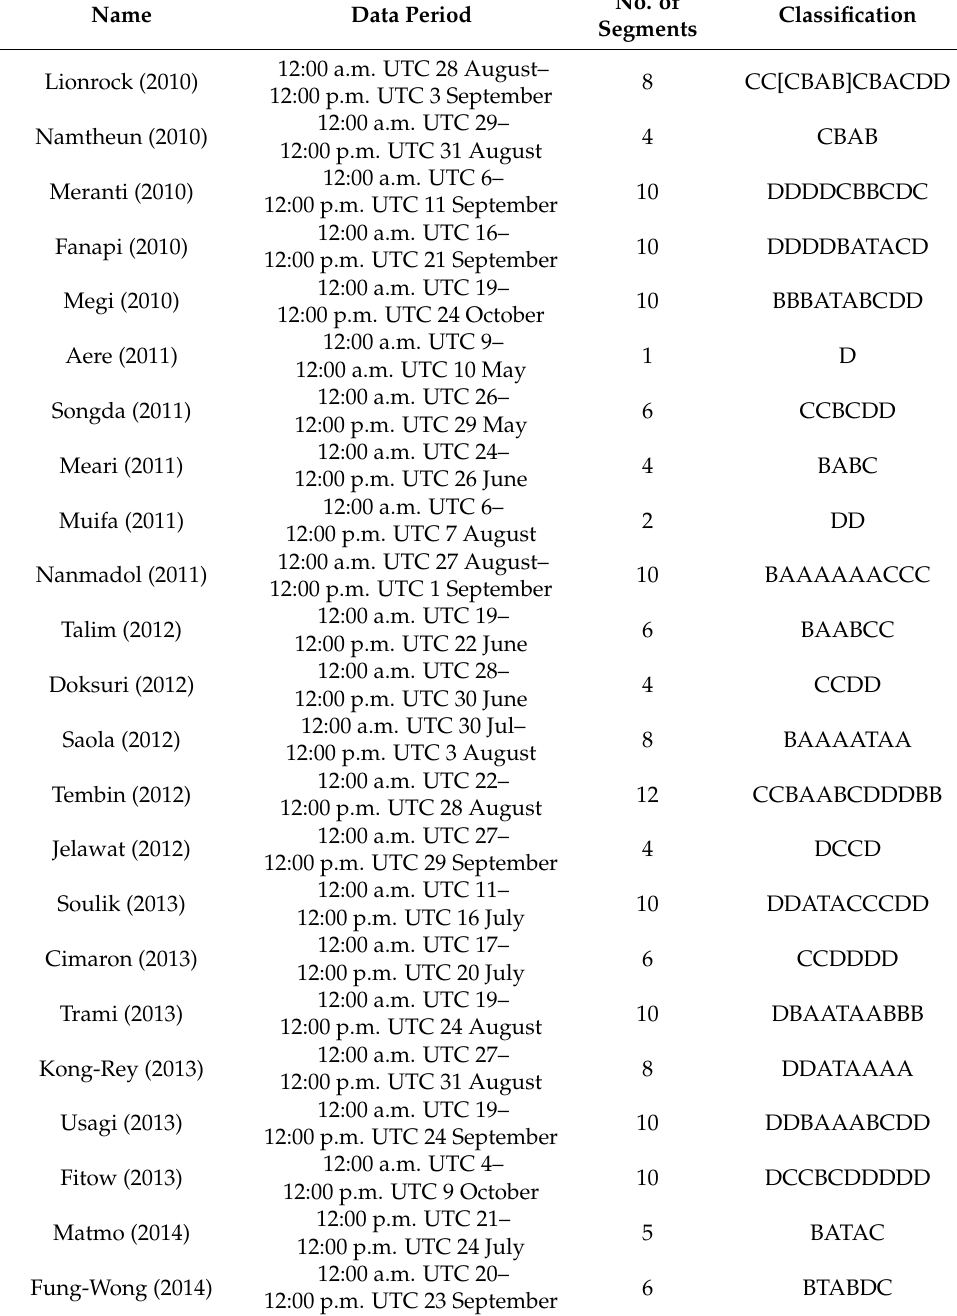
Table 2. List of the 29 typhoon cases, their data period, number of 24 h segments (12:00–12:00 a.m. and 12:00–12:00 p.m. UTC), and classification (group A–D or T10, in chronical order) included